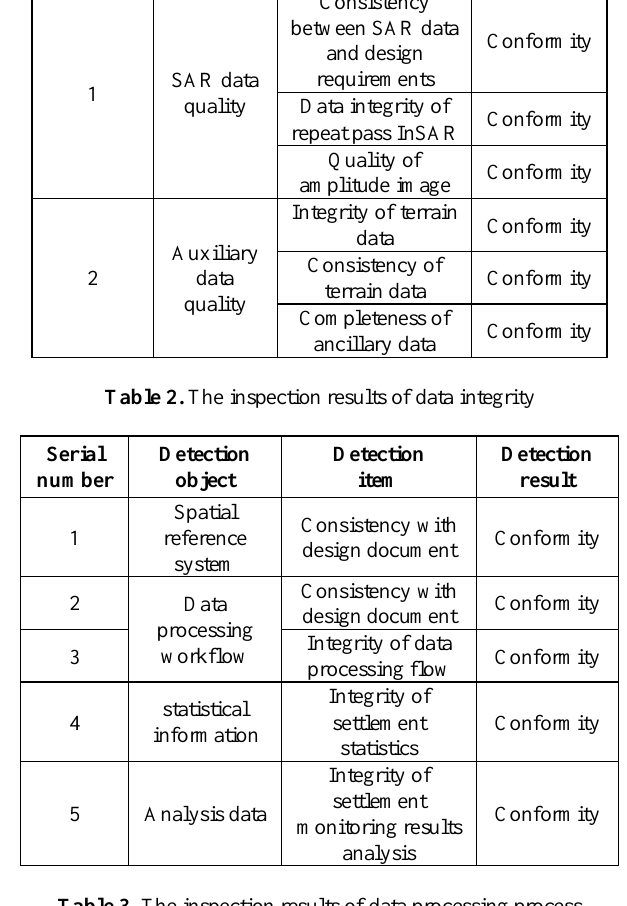
Table 3. The inspection results of data processing process compliance